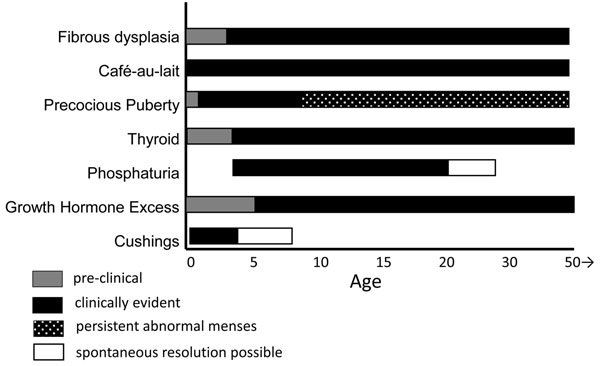
The relative age at which any given aspect of the disease becomes clinically evident is depicted by a solid black bar. Preclinical disease is depicted by gray bars, and ages during which spontaneous resolution is possible for Cushing’s disease and phosphaturia are shown in open bars. The period of time during which abnormal menstruation can be expected is depicted by the stippled bar.